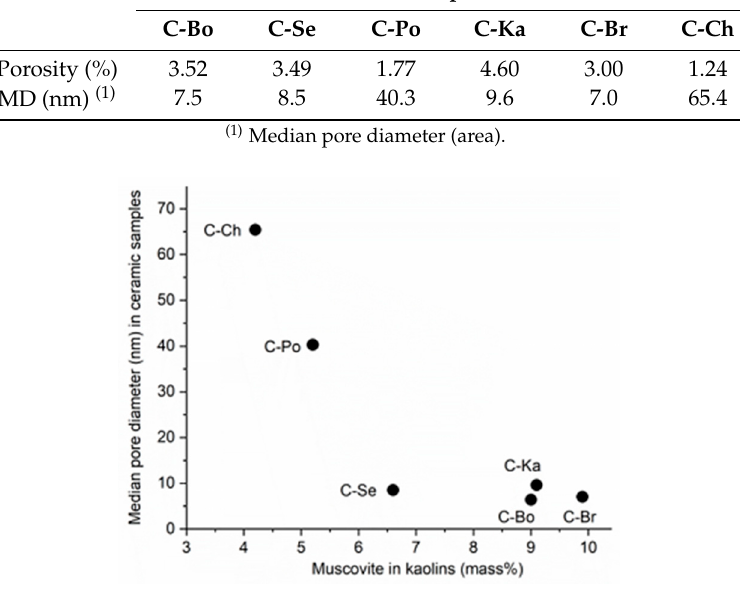
Table 7. Selected characteristics of ceramic samples from the porosimetry measurement. Samples